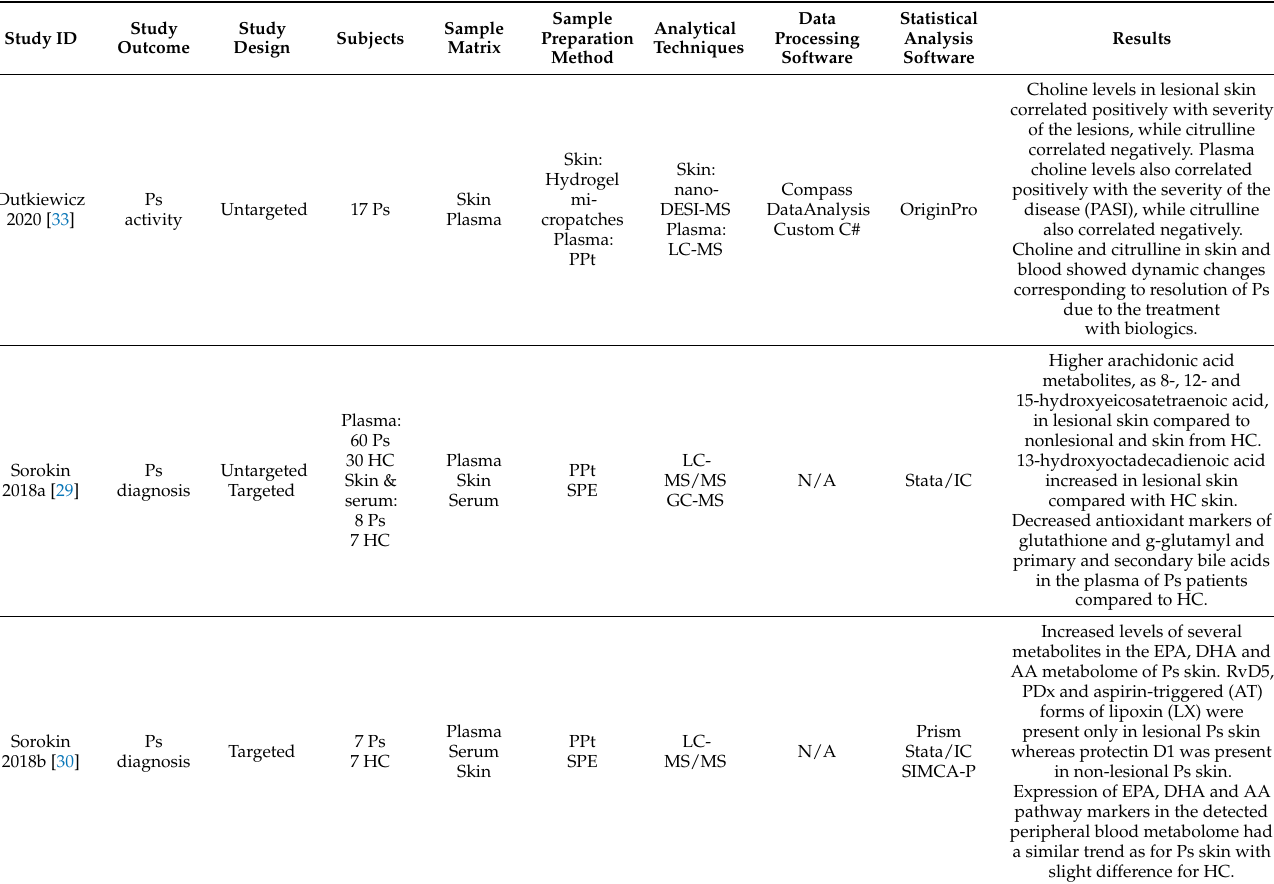
Table 7. Studies in multiple